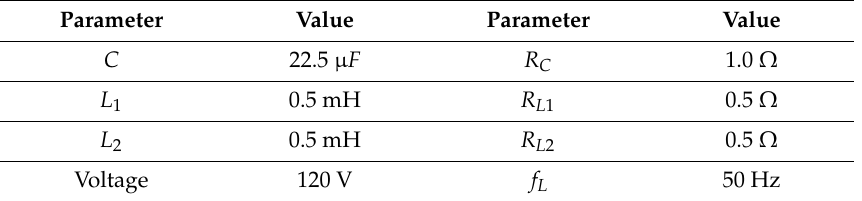
Table 1. Inverter parameter of the considered